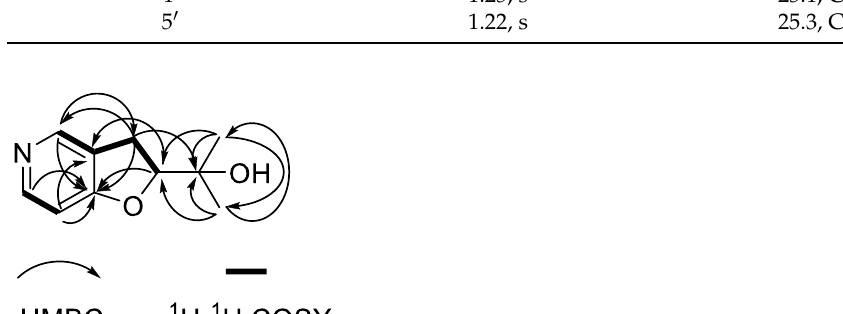
Molecules 2022 , 27 , x FOR PEER REVIEW Figure 3. HMBC (single arrows) and 1 H- 1 H COSY (bold lines) correlations for compound 2.